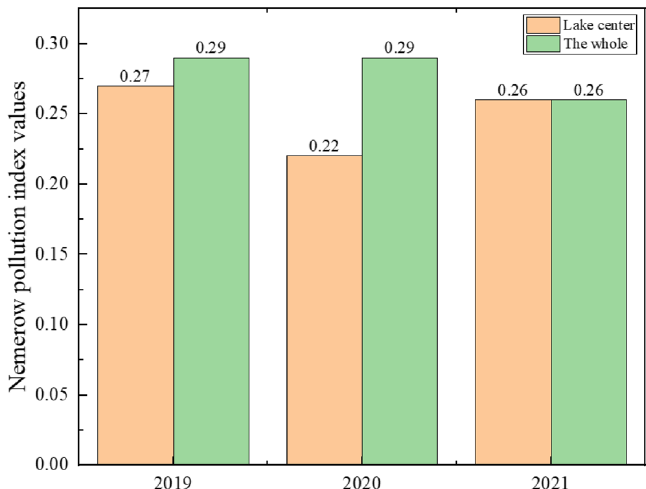
Figure 5. Changes in Nemerow pollution index for the Lake center and The whole from 2019 to 2021.